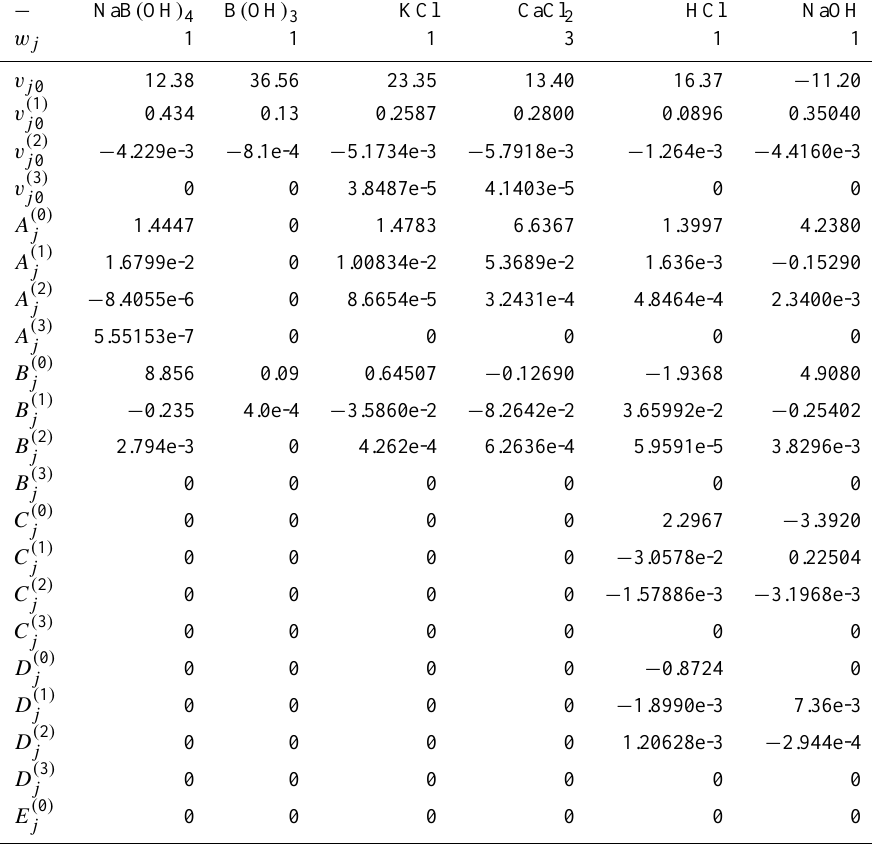
Table 3. Parameters from Eq. (14)